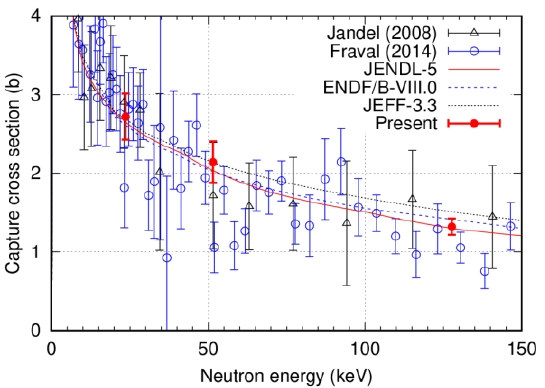
Fig. 8. Neutron capture cross section of 241 Am. The present experimental results are compared with past experimental data and evaluated cross